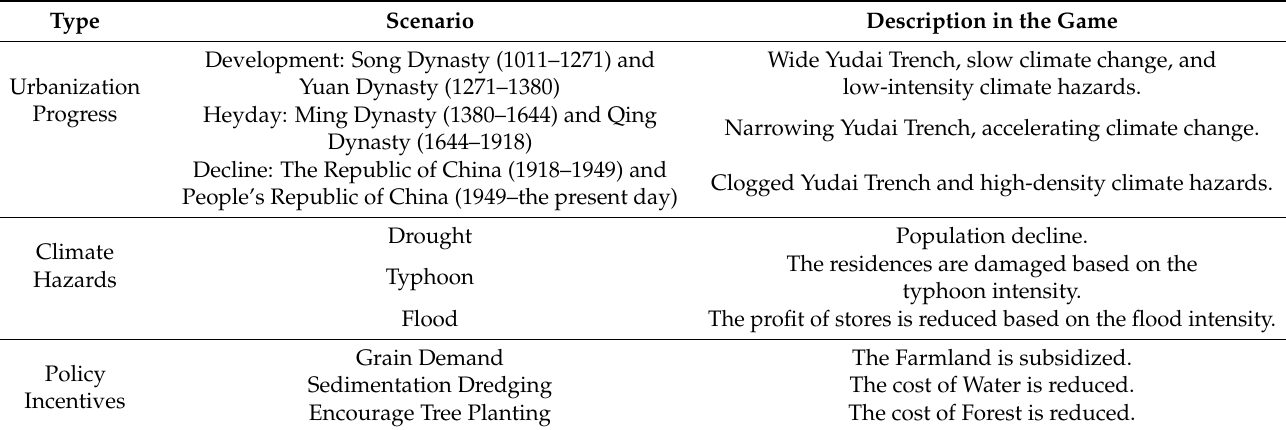
Table 1. Description of the SG’s scenarios.